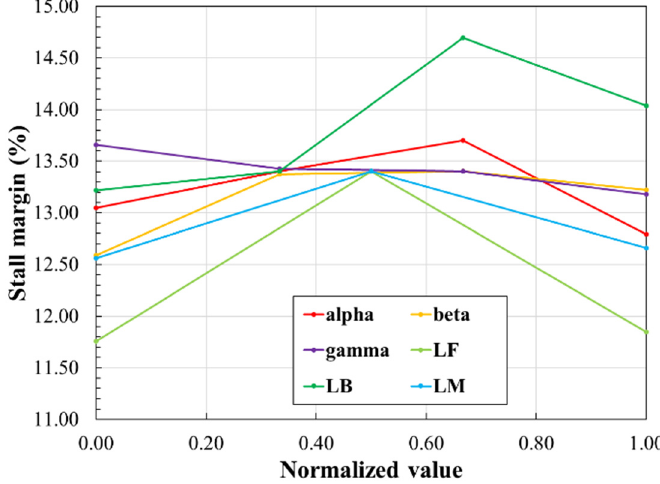
Figure 16. Sensitivity analysis of geometric parameters.